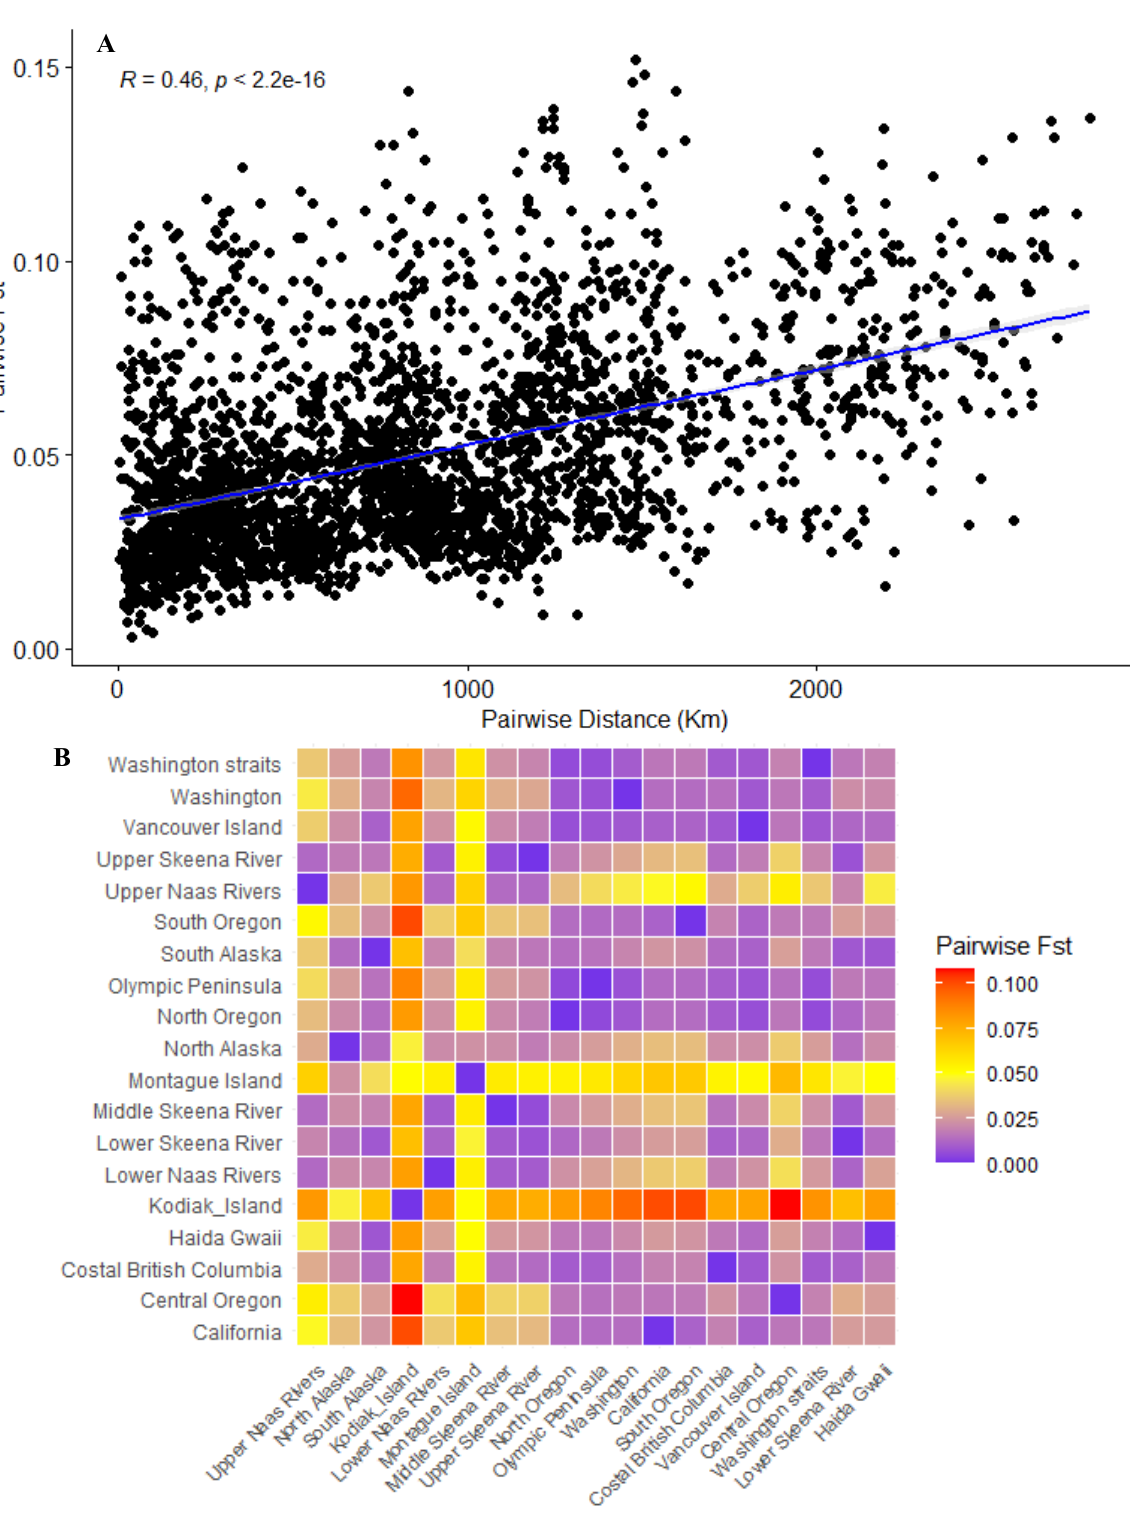
Figure 3. Isolation by distance of the Sitka spruce population. ( A ) Pairwise Fst values for each prove- nance have been plotted against geographic distance (km). ( B ) Pairwise Fst for each geographic region.